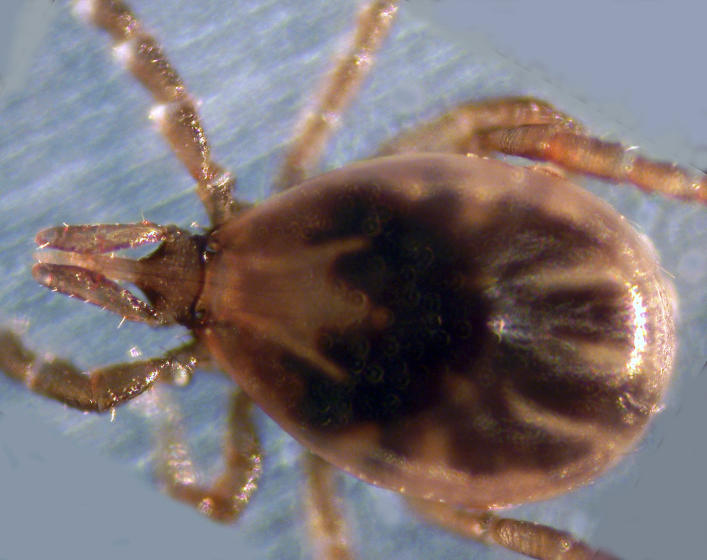
The blacklegged tick (
Ixodes scapularis), the primary vector for Lyme disease in the central and eastern United States.